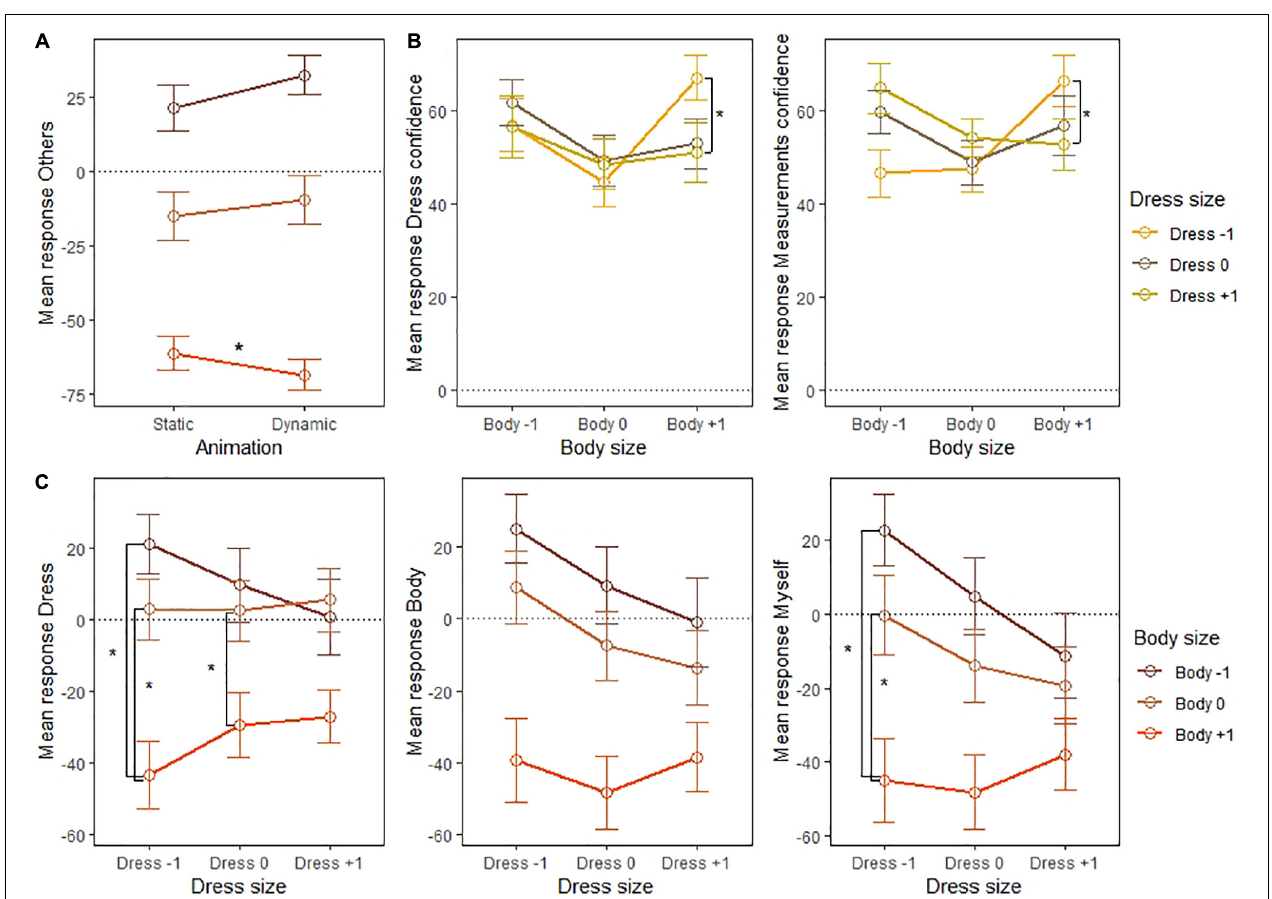
FIGURE 3 | Interaction effects of (A) Animation and Body size for the Others item, (B) Body size and Dress size for the Dress confidence and Measurements confidence items, and (C) Body size and Dress size for the Dress, Body, and Myself items. Dress = How likely do you think it is that this dress fits you? , Dress confidence = How certain are you? , Measurements confidence = How certain are you? (In response to How likely do you think it is that this avatar’s measurements correspond to your own? ), Body = I feel as if the body of the avatar is my own body , Myself = The avatar reflects how I consider myself to be , Others = I consider the avatar to reflect how I want to present myself to others . Body/Dress –1 = One body/dress size smaller than participants’ real body/dress size, Body/Dress 0 = Participants’ real body/dress size, Body/Dress +1 = One body/dress size bigger than participants’ real body/dress